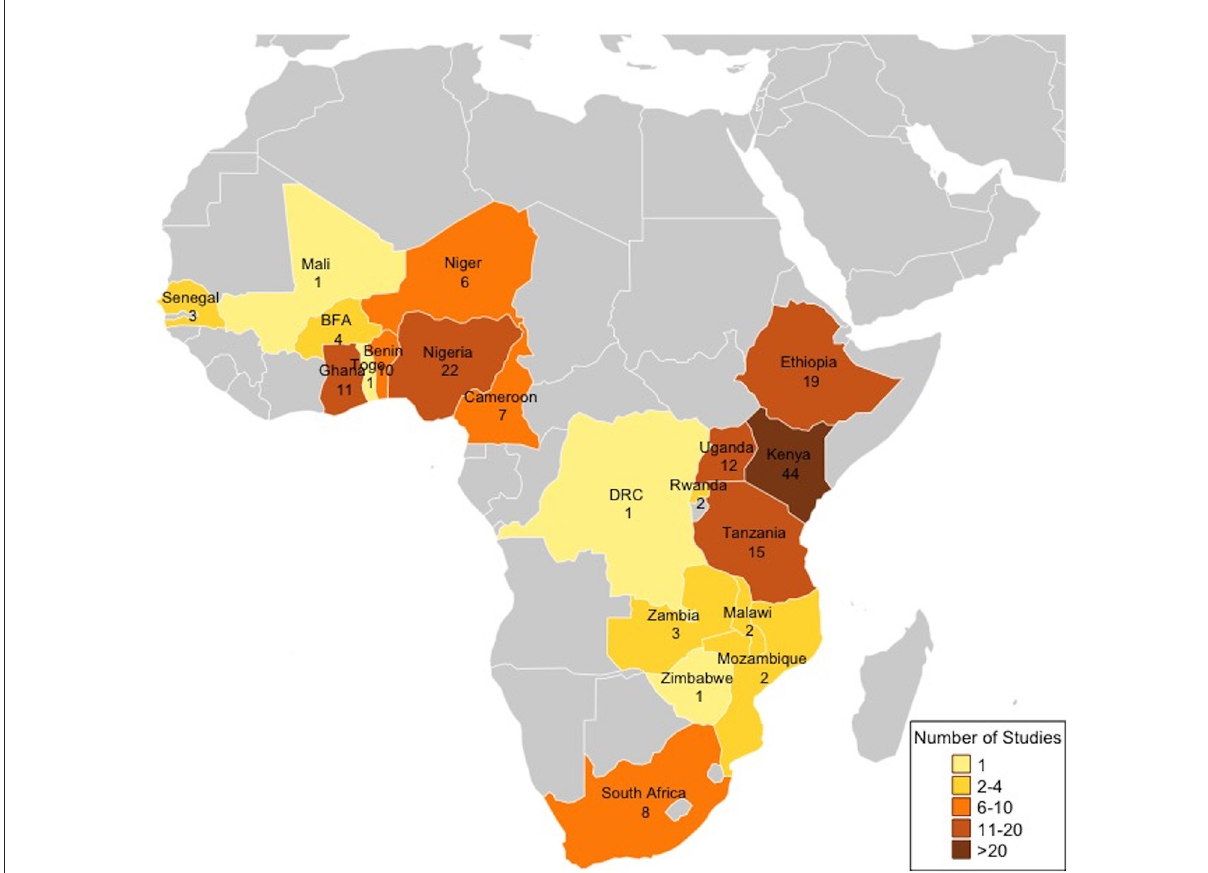
FIGURE2 Distribution map of the countries included in the systematic map; color coded by number of studies recorded per country.